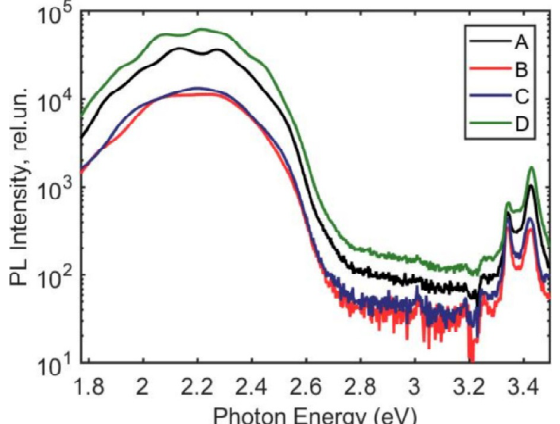
Fig. 7. XRD spectra obtained for samples A, B, C, and D.